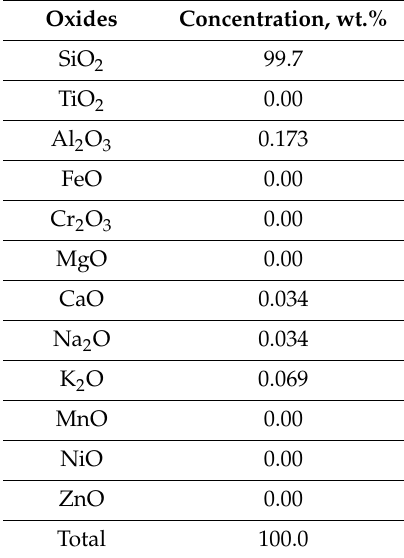
Table 5. The concentration of the chemical components of silica nanopowder (X-ray fluorescence spectrometer “S4